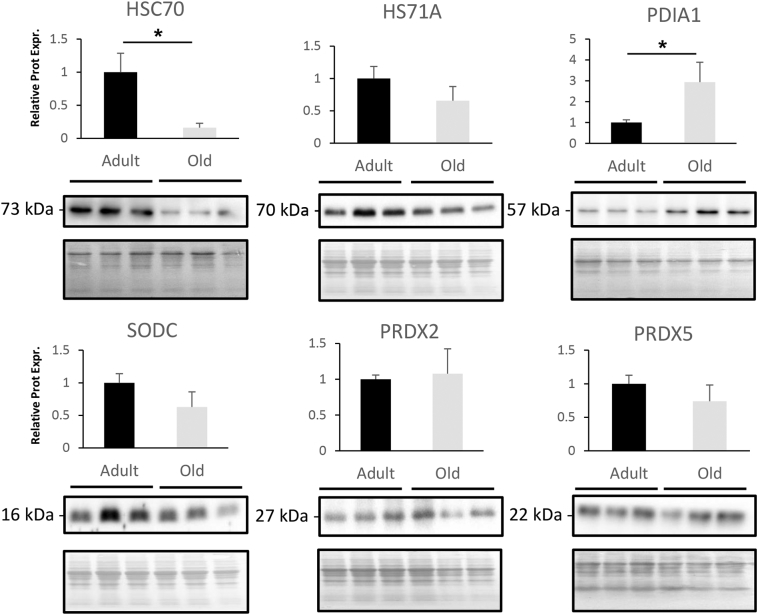
Western blot analysis and relative quantification of selected proteins from protein extracts of quadriceps protein extracts from adult and old mice (N = 3). *P < 0.05 using a two tailed unpaired student t-test. Corresponding Ponceau S stain of total protein on membranes were used as loading controls.